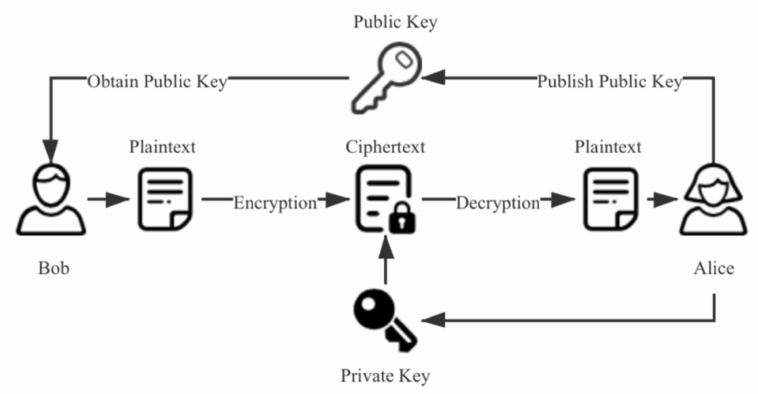
Figure 3. Asymmetric encryption algorithm